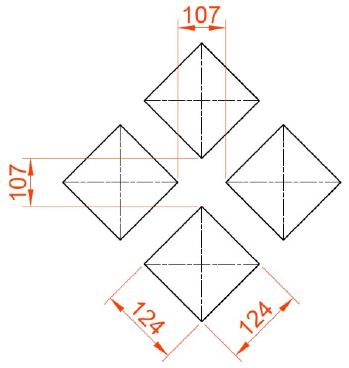
Figure 20. Indented oil pockets, after [122].